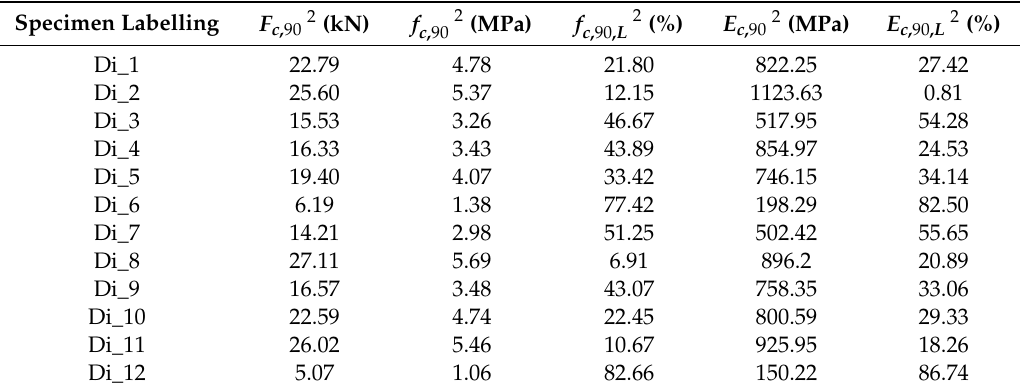
Table 2. Compressive strengths, elastic modulus, and properties loss for deteriorated timber